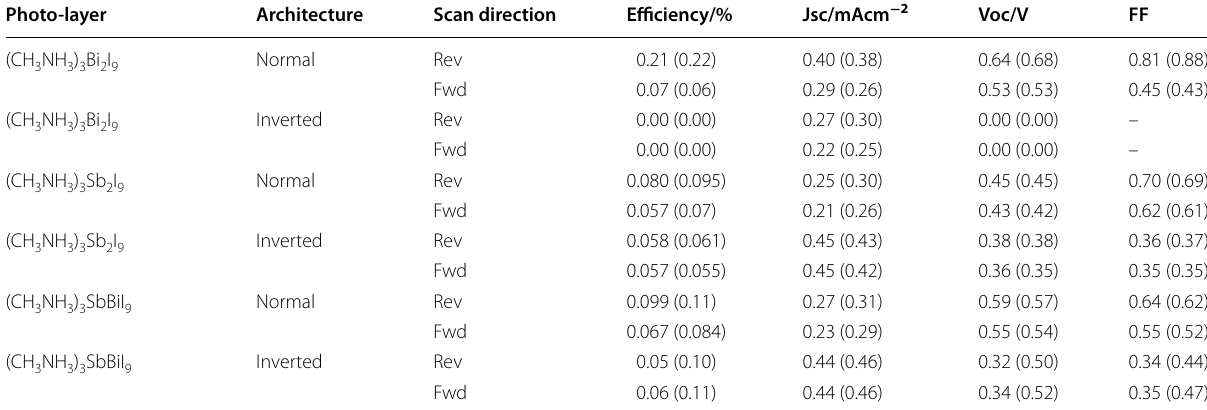
Data shown here represent the average of three independent solar cell parameters. Best representative photovoltaic parameters are shown in the bracket